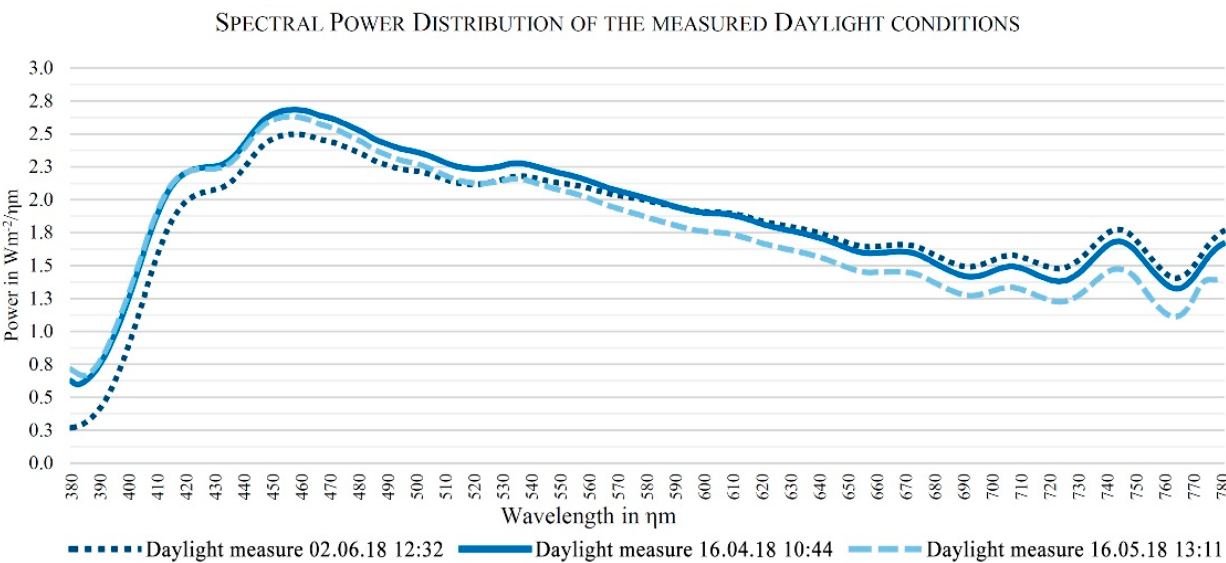
Figure 3. Measuring the SPD and illuminance of the light source and the spectral reflectance of the color samples.